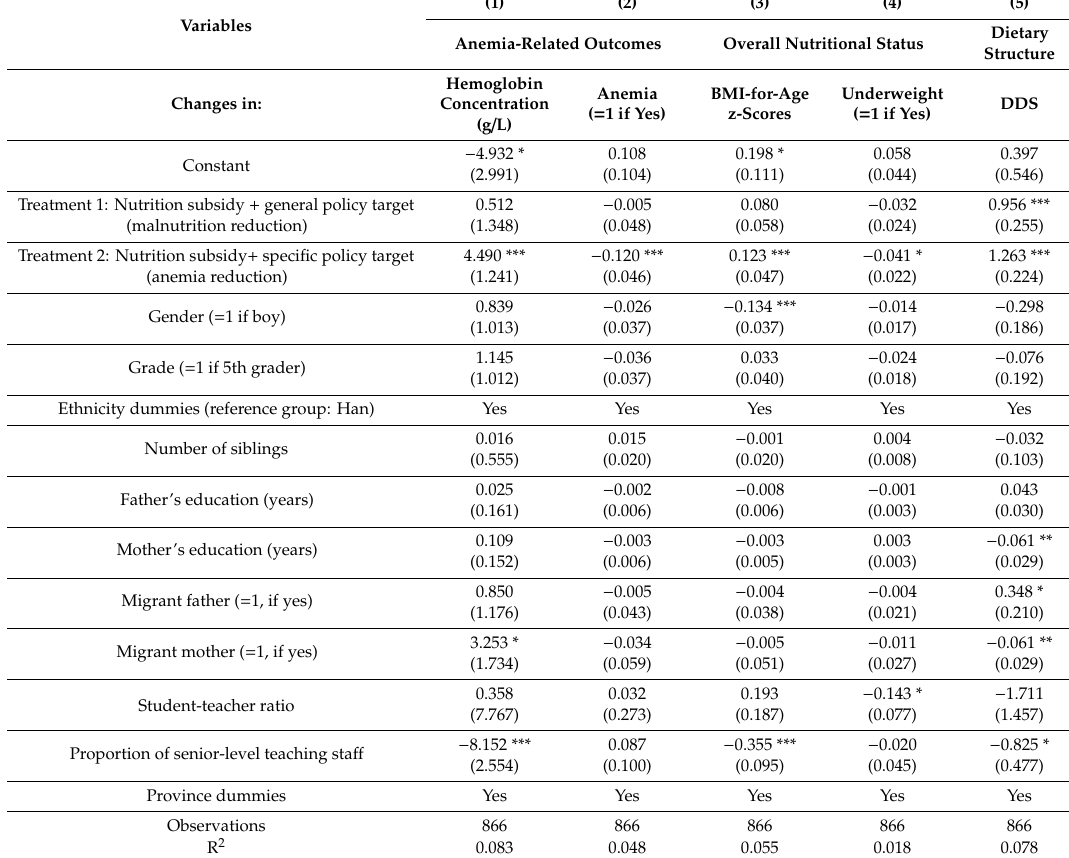
Table A2. Impacts of nutrition interventions on students’ health outcomes and dietary